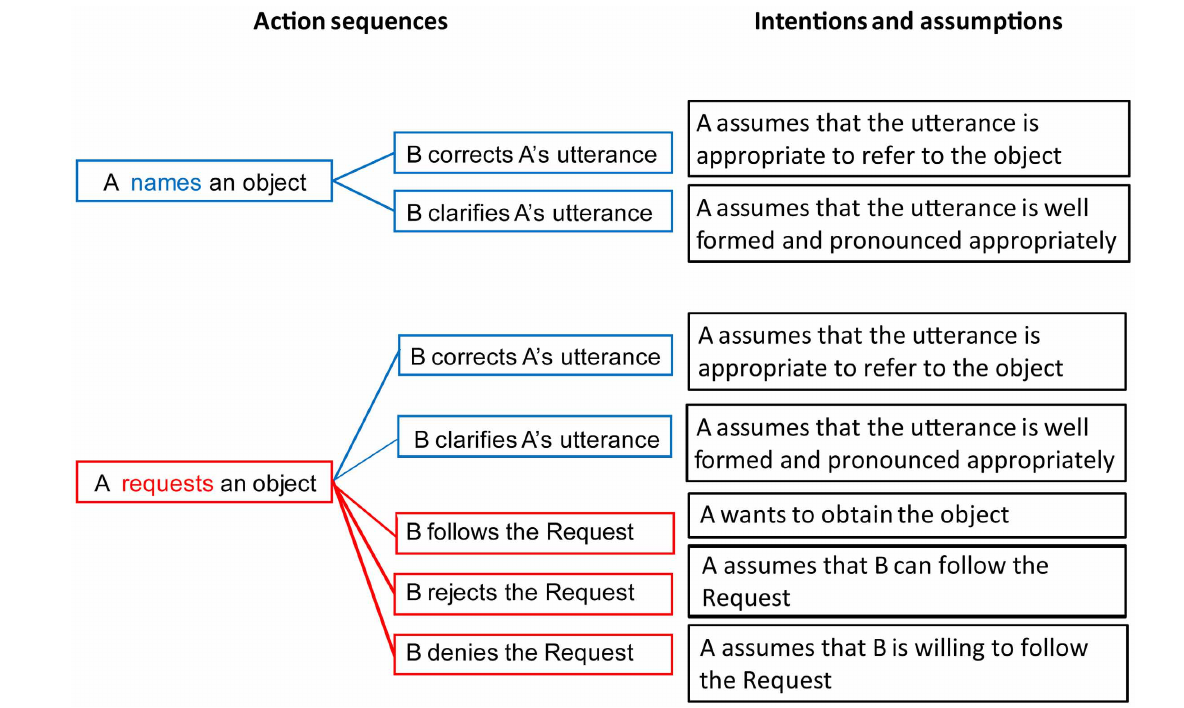
FIGURE 1 | Comparison of pragmatic properties of the speech acts of Naming (Top) and Requesting (Bottom). Action sequence schemes (Left) show typical actions following the speech acts, which are closely linked to the intentions and assumptions (Right) characterizing the speech